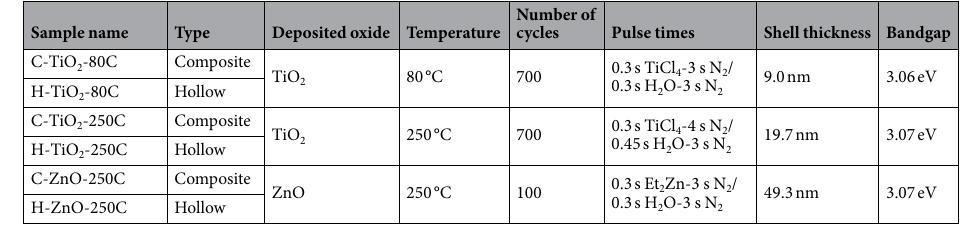
Table 1. Parameters of the ALD process, shell thicknesses and